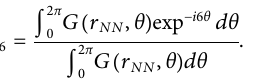
Figure 9 are a spatial average of each fi eld, < σ BSM ( (cid:2)r,t ) > t